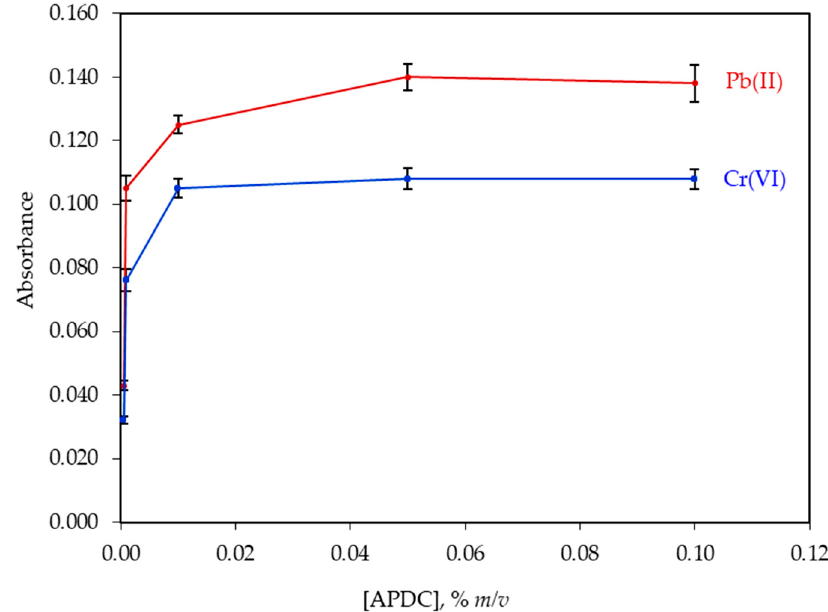
Figure 4. Effect of ammonium pyrrolidine dithiocarbamate (APDC) concentration on the absorbance of 100.0 μ g·L − 1 Pb(II) and 100.0 μ g·L − 1 Cr(VI). All other experimental parameters as presented in Table 1. Error bars were calculated based on standard deviation values ( n = 5).